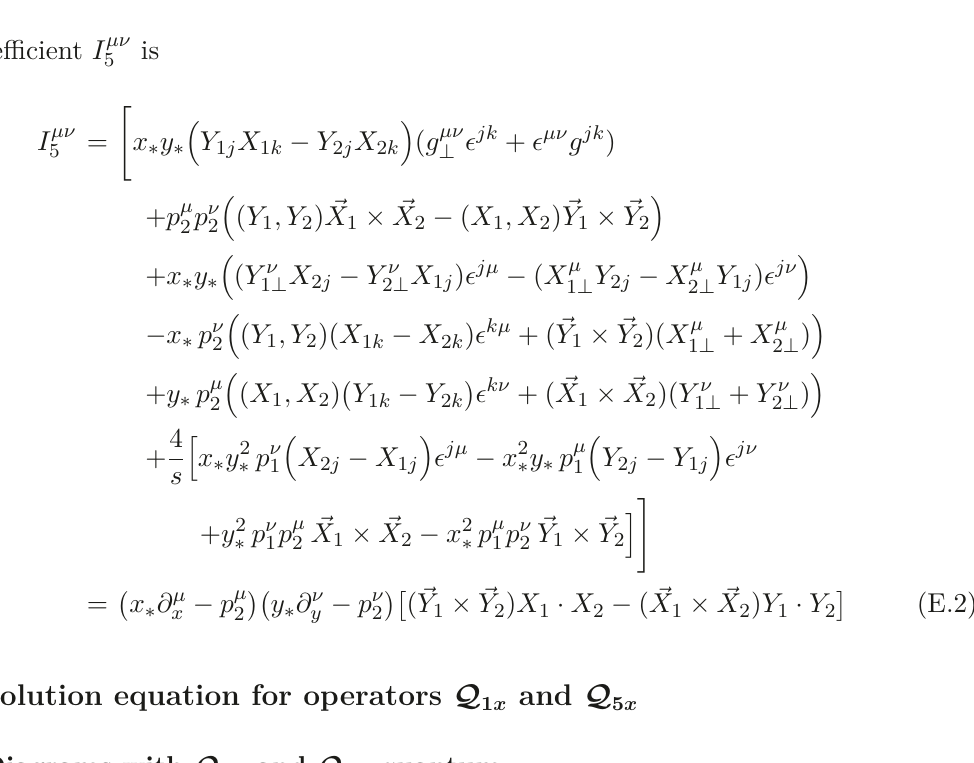
Figure 14 . Diagrams with quantum quarks. Blue fermion lines are quantum fields, while red fermion lines are classical fields. The gray circle with a cross on it represents here the ǫ ij F ij classical